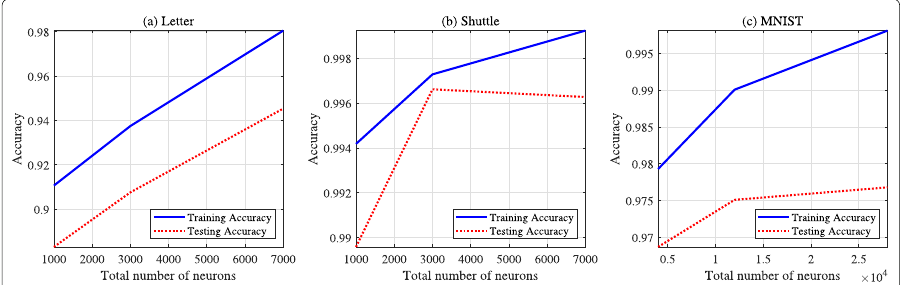
Fig. 2 Training and testing accuracy against size of one instance of HNF using ELM feature vector in the first layer. Size of an L -layer HNF is represented by the number of random matrix-based nodes, counted as (cid:13) ( l ) . Here, L = 3 for all three datasets. The number of nodes in the first layer ( n ( 1 ) ) is set L n ( 1 ) + l = 2 2 n according to Table 1 for each